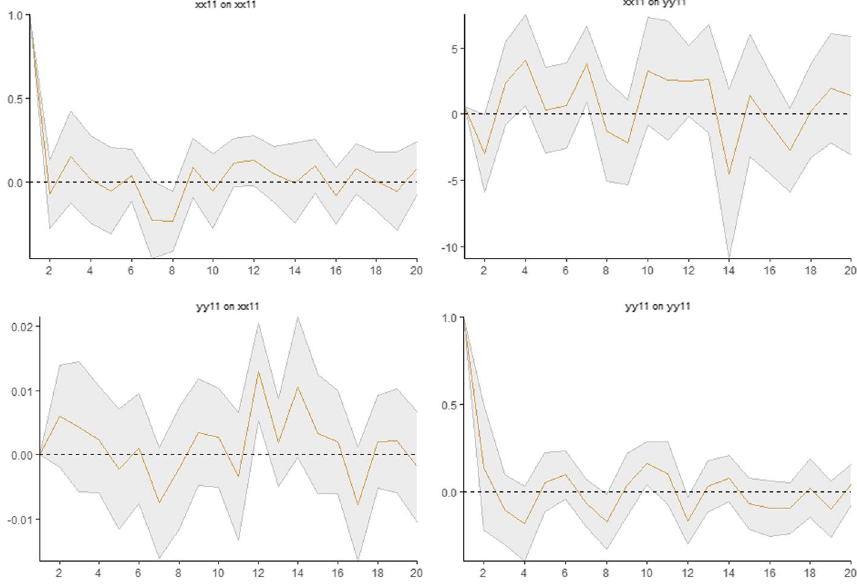
Fig. 12 The subperiod analysis of low-return regime for the period in which CPI < IR (Positive interest rates)